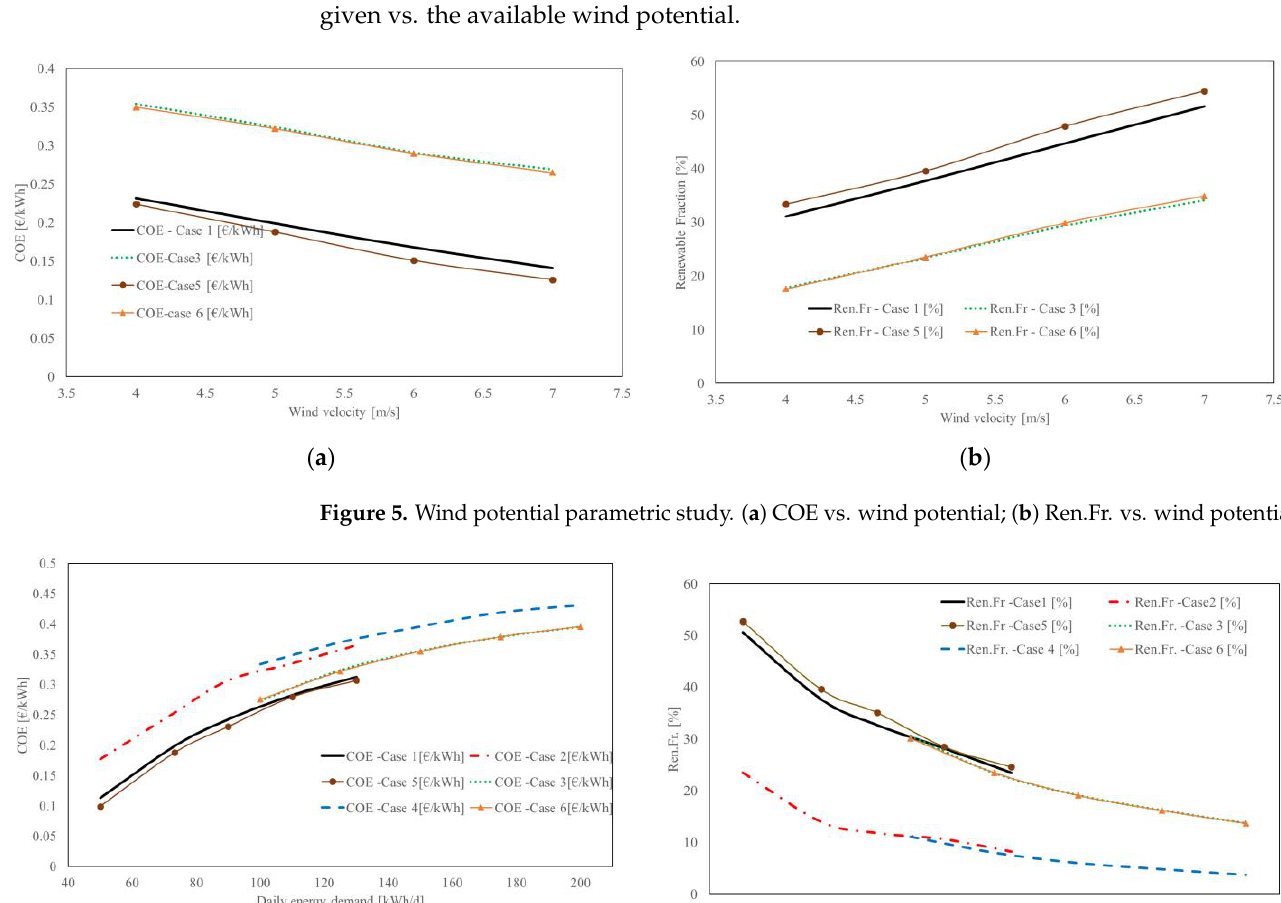
( b ) Figure 4. Solar potential parametric studies result. ( a ) COE vs solar potential; ( b ) Ren.Fr. vs. solar potential. In all the examined cases, the cost of energy decreases as the solar potential increases, while the percentage of load covered by renewables increases at a faster rate. The best performance is achieved for the load type A profile, with the minimum energy cost corre- sponding to the second examined wind pattern type (when there is low yearly and daily